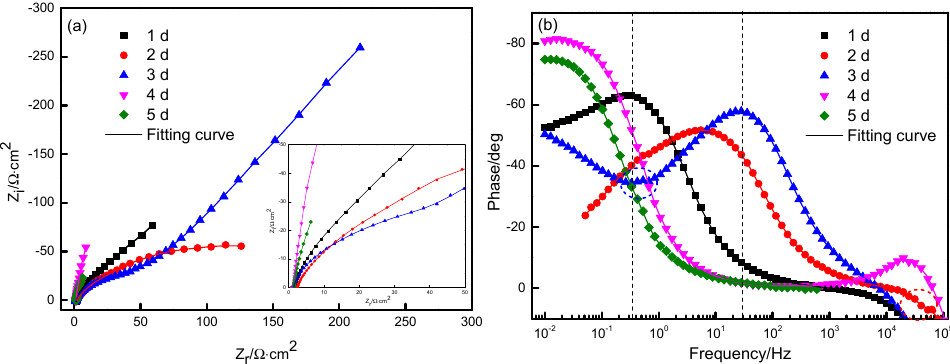
Figure 8. EIS of Q235 steels with different corrosion times. ( a ) Nyquist plots; and ( b ) Bode plots. The electrochemical equivalent circuit (EEC) was used to interpret the EIS data